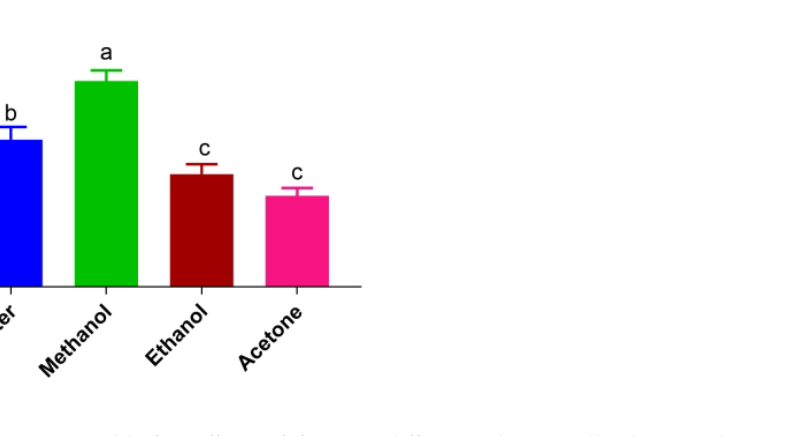
Figure 2. Extraction yield of Caralluma edulis using different solvents. All values are the mean ± SD ( n = 3). Means of a column with different letters significantly differ by Tukey’s test at p < 0.01. Table 2. Effect of different solvents on phenolic, flavonoid, and alkaloid content of Caralluma edulis . The impact of these solvents on the chemical composition of Caralluma edulis was also determined. Data in Table 2 demonstrated the highest extraction of phenolics (14.3 Extraction Solvent